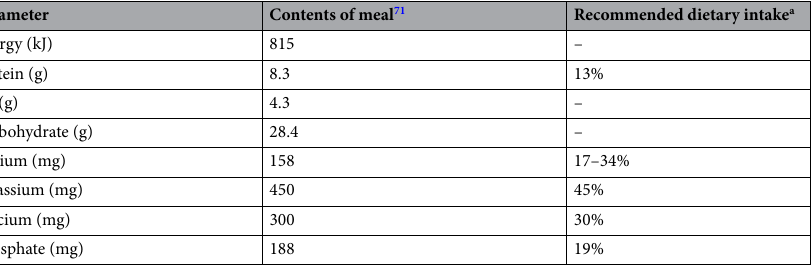
Table 1. Nutritional information for standardised meal (Sanitarium Up&Go liquid breakfast; 250 mL, vanilla flavour). a Percentage of recommended dietary intake based on Australian adult male 72 (where generalised recommendations are